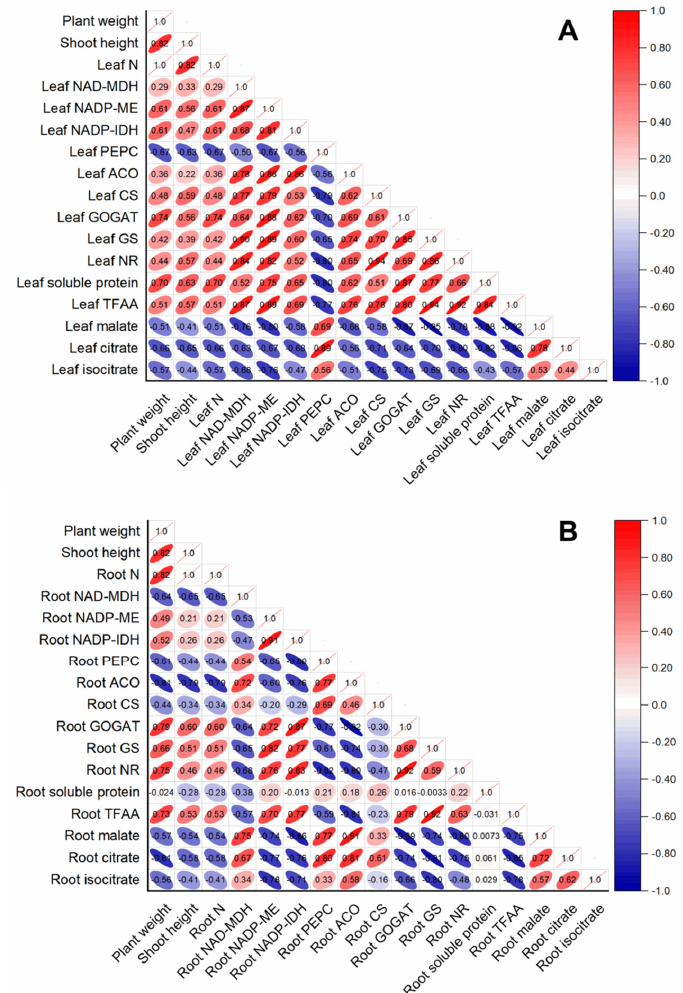
Figure 6. Correlation analysis of variables in rice leaves ( A ) and root ( B ) in response to different N treatments. The direction and color of the ellipse represent the positive or negative relationship between two variables. The number in the ellipse indicates the correlation coefficient between two variables.